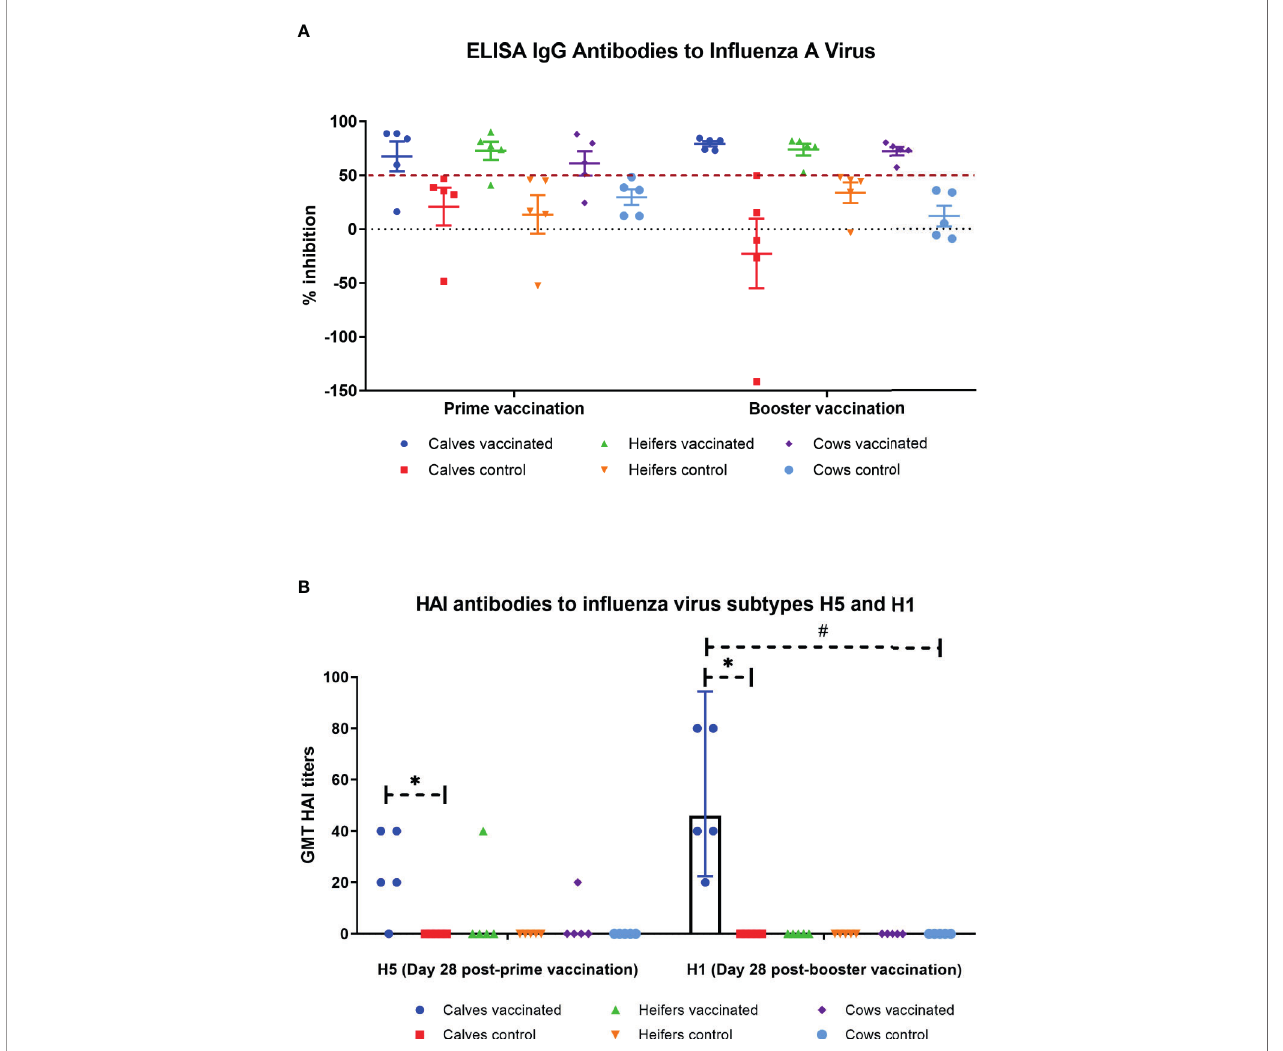
FIGURE 4 | IgG antibodies to in fl uenza virus type A by ELISA (A) and hemagglutinin inhibition (HAI) antibodies (B) to in fl uenza virus subtypes H5 and H1 (B) in calves, heifers and cows for 28 days after prime and booster vaccination. The calves, heifers, and adult cows in the vaccinated group were immunized twice via the subcutaneous route at an interval of 28 days with vaccines generated from the IVV subtypes H5N1 (prime vaccination) and H1N1 (booster vaccination). Animals in the control group were subcutaneously injected with 1.0 ml of 20% Montanide Gel01 adjuvant in PBS. ELISA results were considered positive for optical density inhibition >50%. The HAI assay data is given as Geometric mean titer (GMT) with a con fi dence interval of 95%. * P = 0.0118 − P < 0.0001 vs. appropriate controls; # P < 0.0001 vs. heifers and cows. Statistical analysis was performed using two-way ANOVA followed by Tukey ’ s multiple comparisons test. P values < 0.05 were considered signi fi